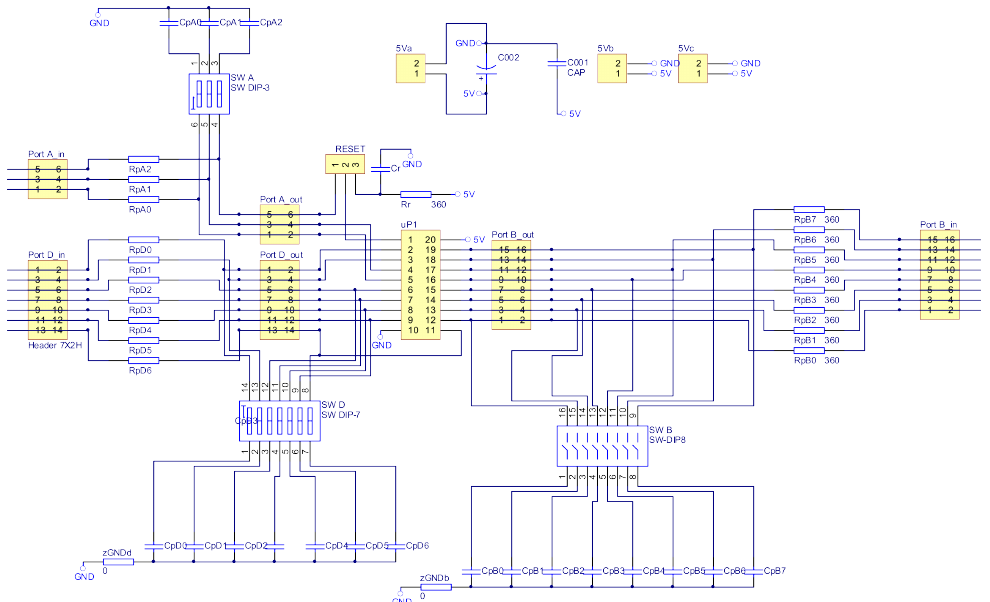
Figure 21. Schematic diagram of the construction of an electronic commutator with ATtiny2313 microcontroller.